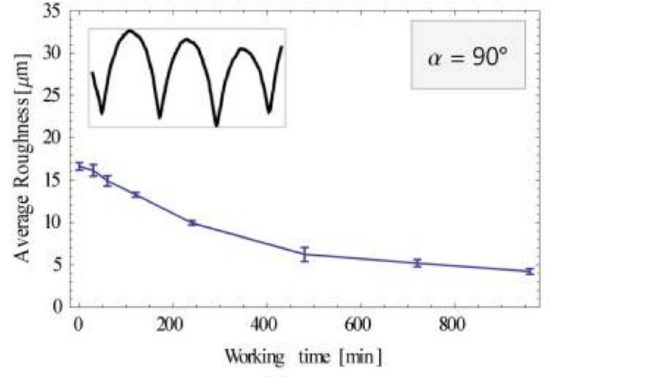
Figure 3. Barrel finishing operation.